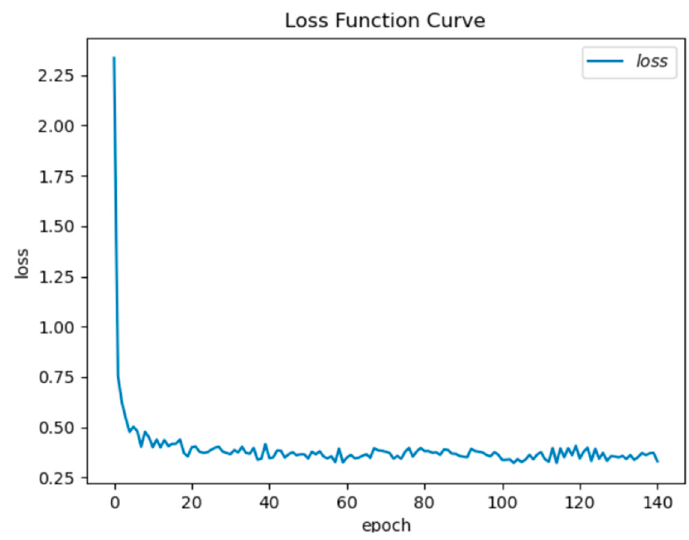
Figure 12. Correspondence map of epoch and loss value.